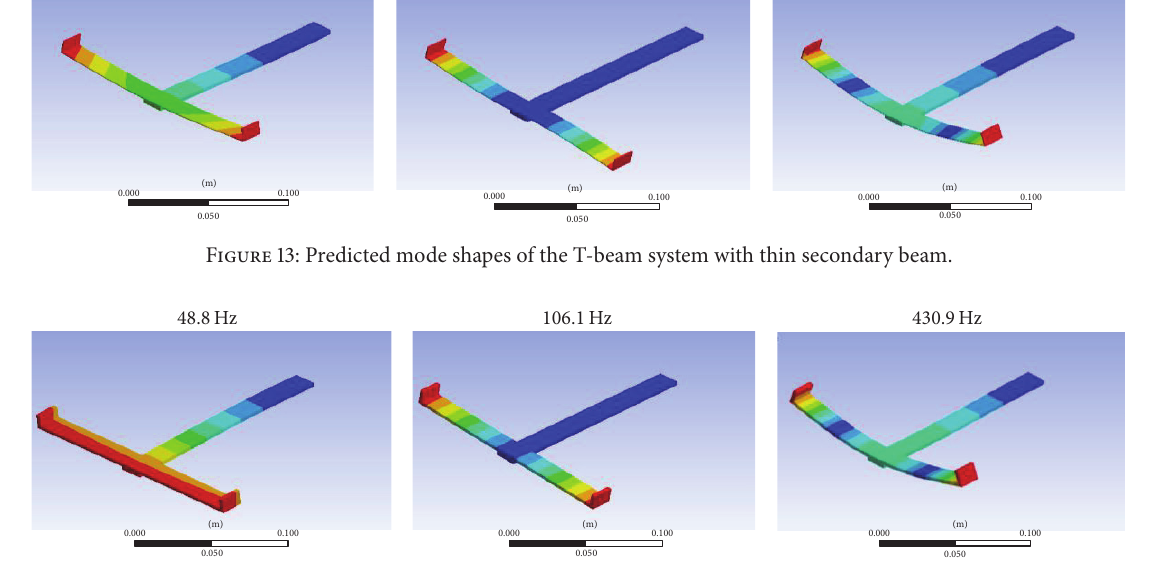
Figure 14: Predicted mode shapes of the T-beam system with thick secondary